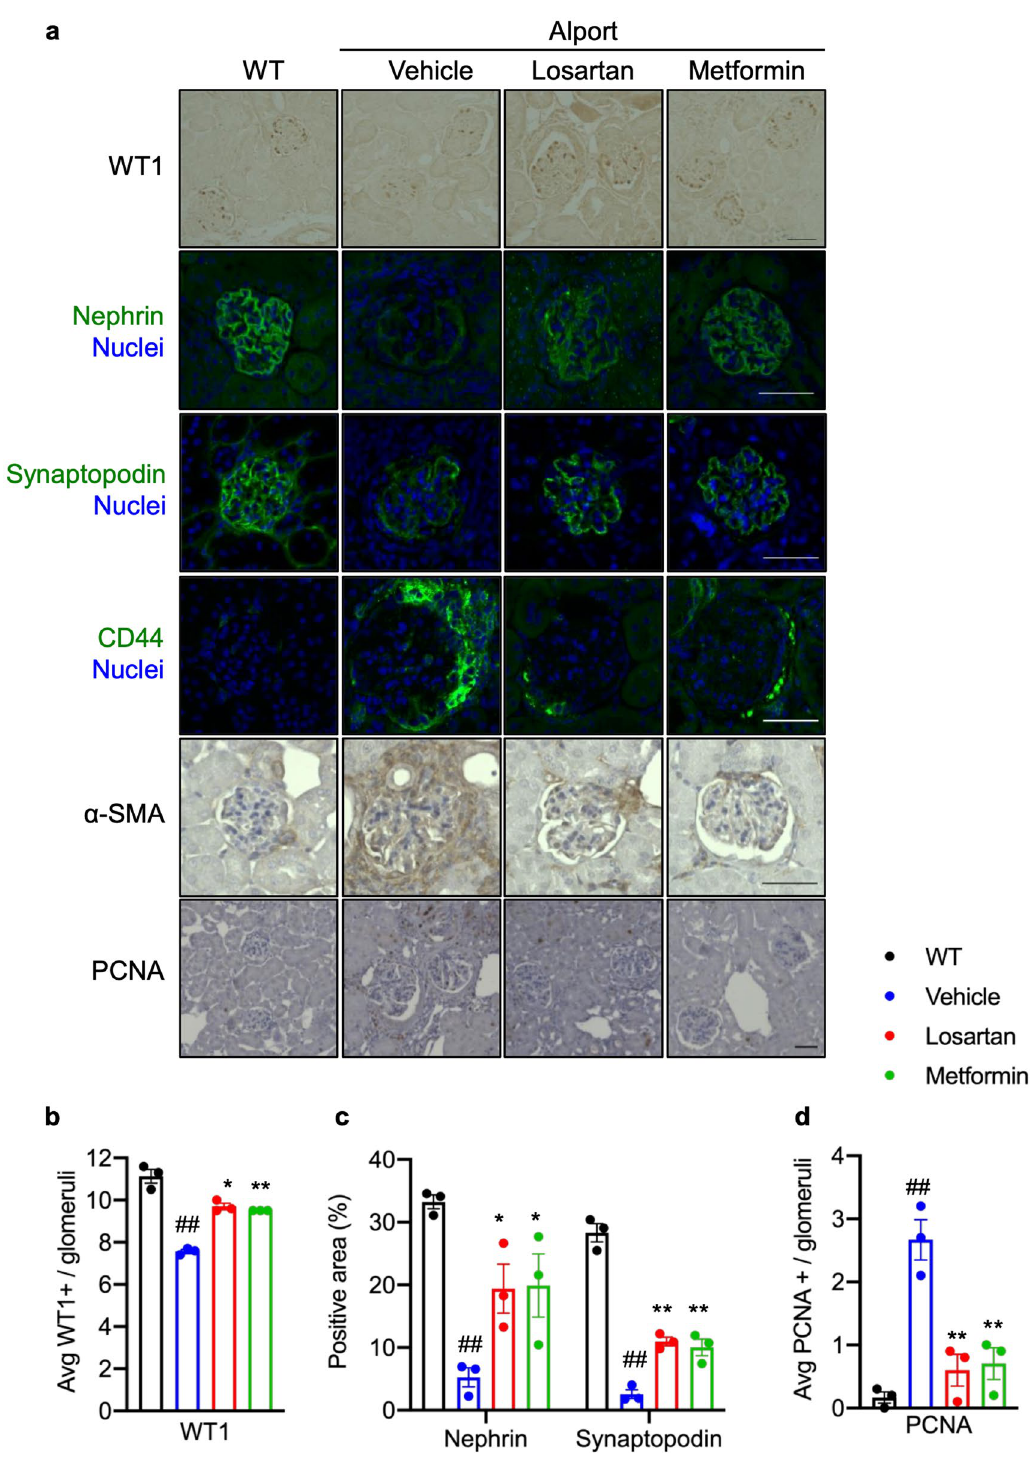
Figure 6. Metformin protects against podocyte dysfunction in Col4a5 G5X Alport syndrome mice. ( a ) Visualization of indicated podocyte and glomerular cell proteins in renal tissue sections. Scale bars, 50 μm. ( b ) Quantification of WT1-positive cells in the glomerulus showed losartan or metformin protected against podocyte loss in late stage C57BL/6 Col4a5 G5X vAlport syndrome mice. ( c ) Quantification of nephrin- and synaptopodin-positive area in the glomerulus showed that the decrease of these podocyte proteins in glomerulus was suppressed in losartan- or metformin-treated C57BL/6 Col4a5 G5X Alport syndrome mice. ( d ) Quantification of PCNA-positive cells in the glomerulus showed the number of proliferating cells in glomerulus was decreased in losartan- or metformin-treated C57BL/6 Col4a5 G5X Alport syndrome mice. Data are expressed as the means ± S.E. (n = 4 per group). P values were assessed by Dunnett’s test ( ## P < 0.01 vs WT. * P < 0.05, ** P < 0.01 vs